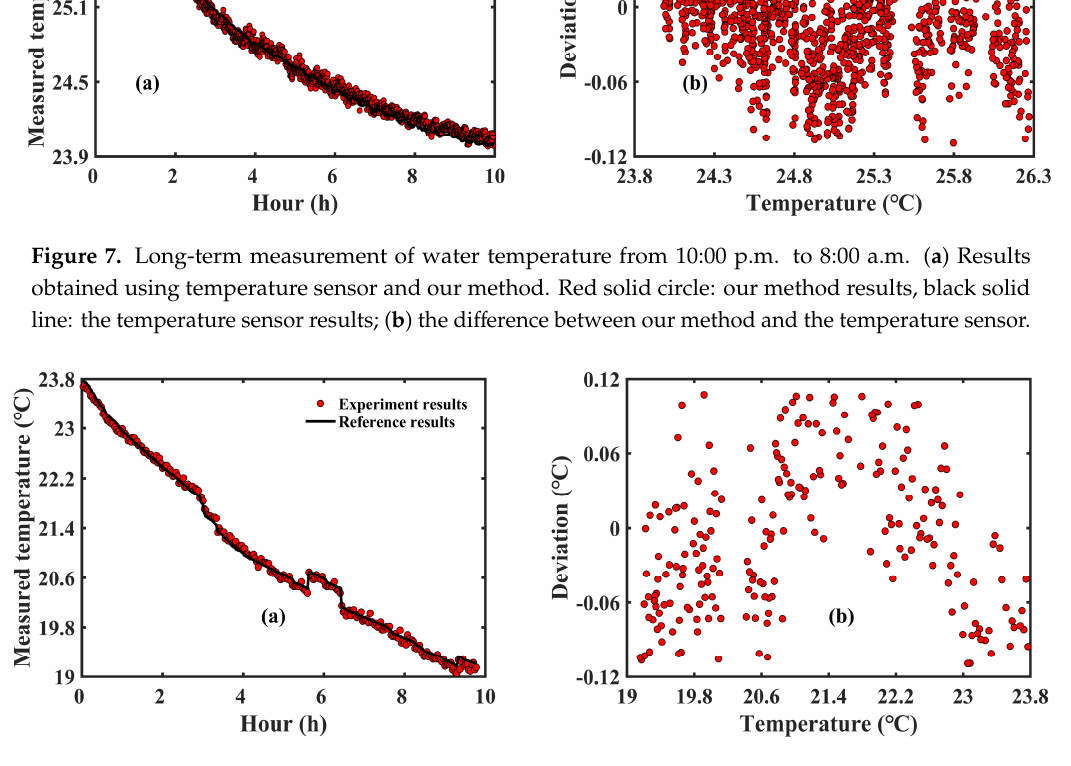
Figure 8. Long-term measurement of water temperature 9:00 p.m. to 7:00 a.m. ( a ) Results obtained using temperature sensor and our method. Red solid circle: our method results, black solid line: the temperature sensor results; ( b ) the difference between our method and the temperature sensor.